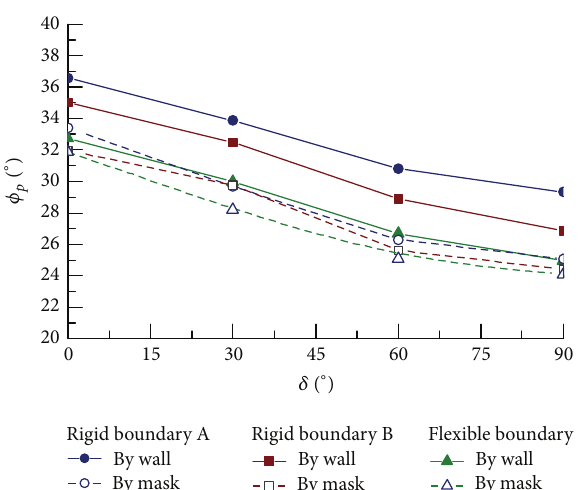
Figure 11: Comparison of peak friction angle 𝜙 𝑝 under different boundary conditions.